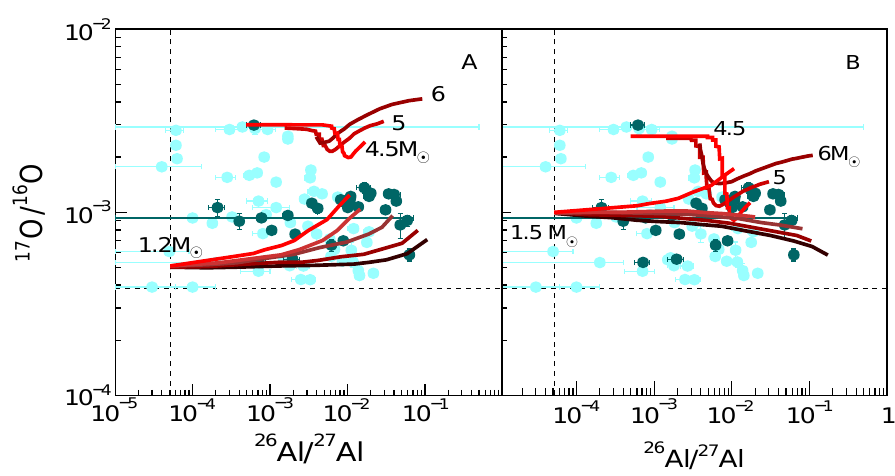
Figure 6. The same as Figure 4 but for the 17 O/ 16 O isotopic ratio versus the 26 Al/ 27 Al one. Dashed lines mark to the solar values for 17 O/ 16 O and 26 Al/ 27 Al. Panel ( A ) refers to calculations run with reaction rates of set A and Panel ( B ) to calculations run with the set